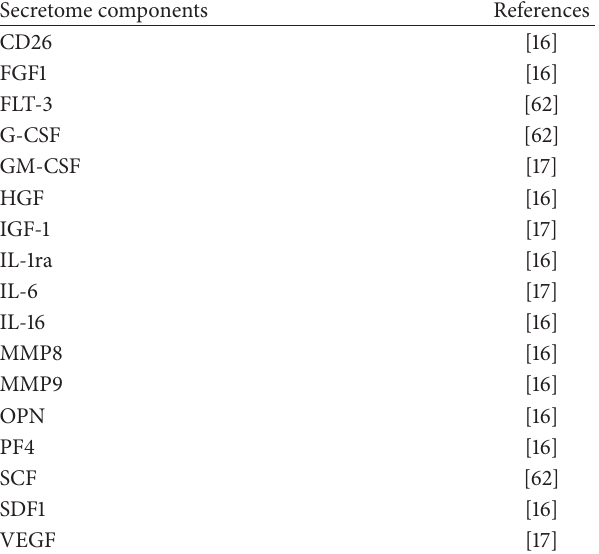
Table 3: List of secretome components (cytokines, growth fac- tors, and proteinases) from adult stem cells (e.g., bone marrow- derived stem cells and adipose mesenchymal stem cells) that can be potentially used in SG regeneration strategies. More details about each secretome component can be found in [18, 23]. FGF: fibroblast growth factor; FLT3: Fms related tyrosine kinase 3; G- CSF: granulocyte-colony stimulating factor; GM-CSF: granulocyte macrophage-colony stimulating factor; HGF: hepatocyte growth factor; IGF: insulin growth factor; IL: interleukin; MMP: matrix metalloproteinase; OPN: osteopontin; PF4: platelet factor 4; SCF: stem cell factor; SDF1: stromal cell derived factor-1; VEGF: vascular endothelial growth